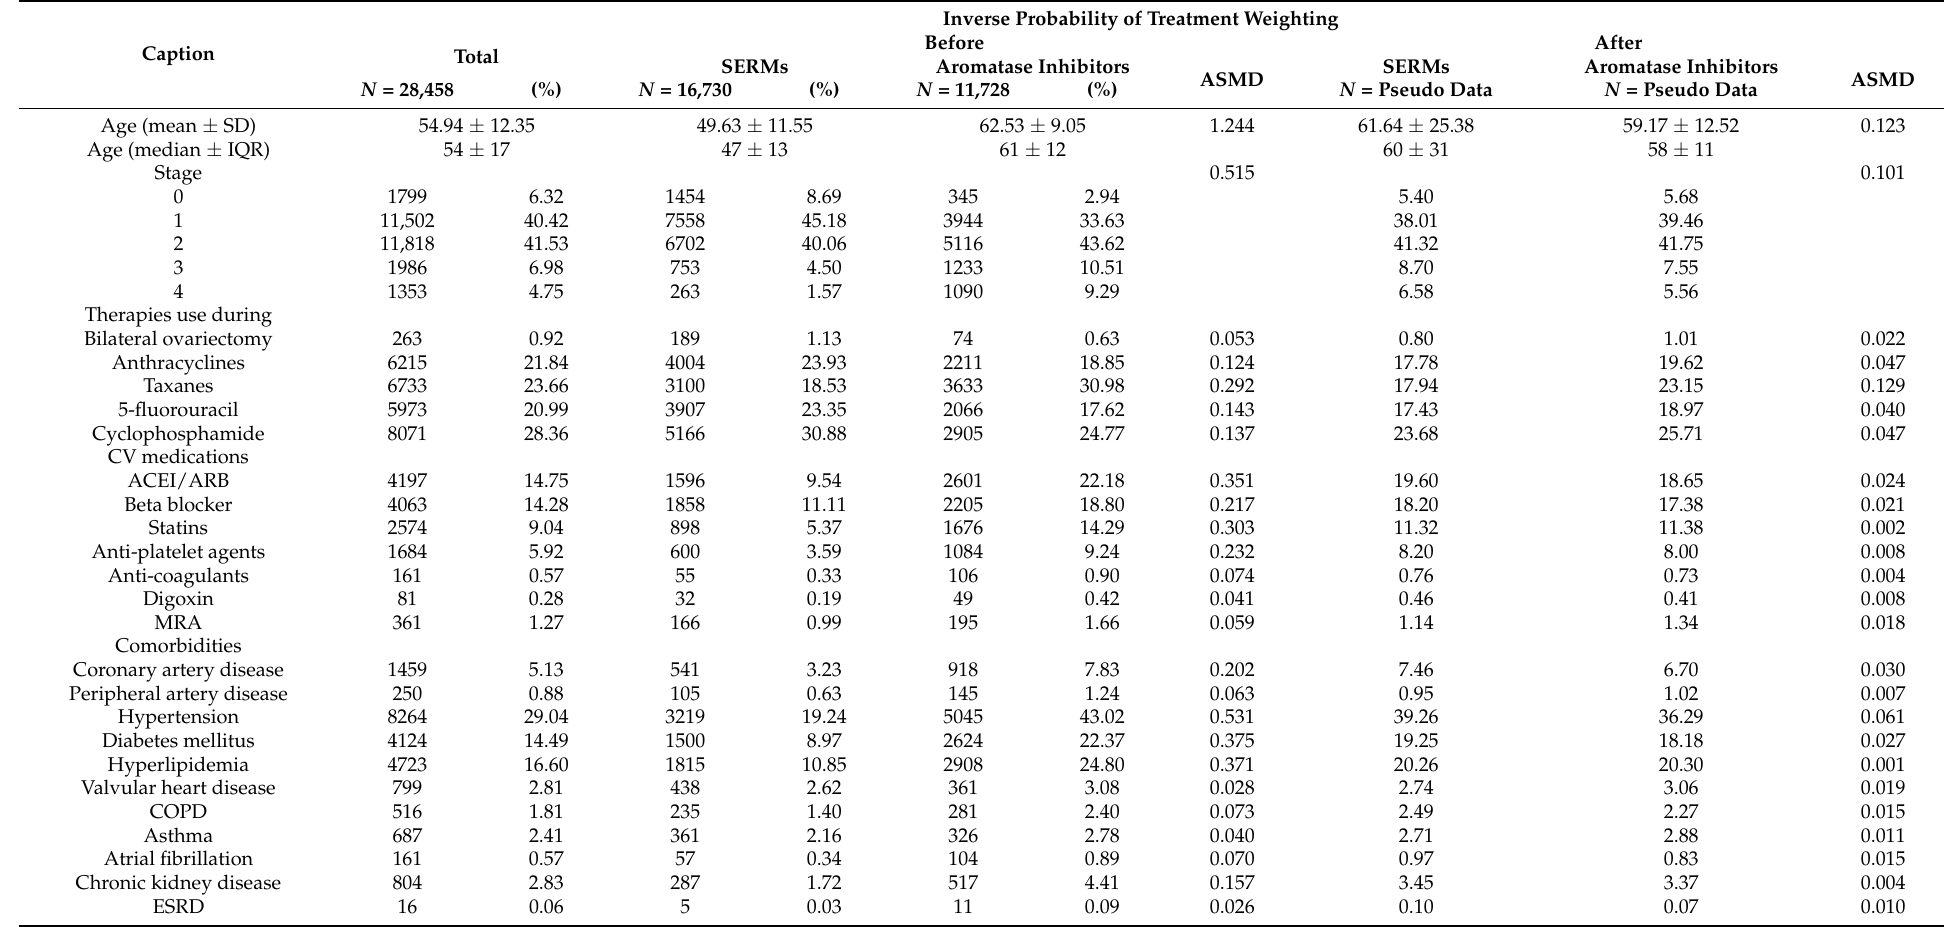
Table 1. The baseline characteristics of breast cancer patients treated with either Aromatase inhibitors (AIs) or selective estrogen receptor modulators (SERMs) before and after inverse probability of treatment weighting